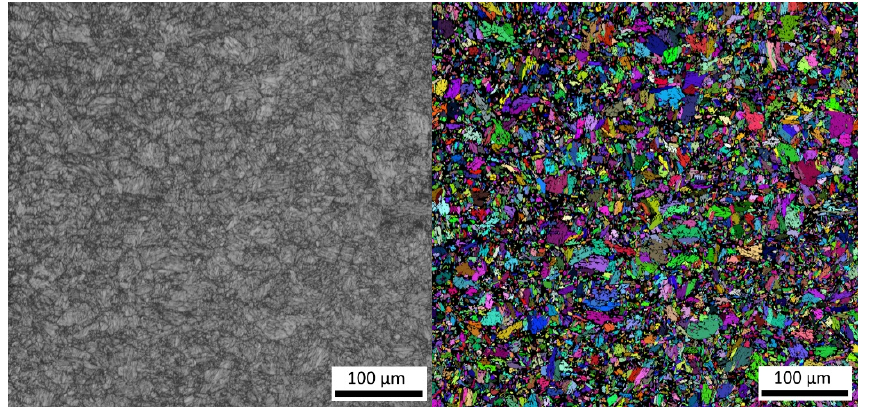
Figure 1. The martenzite–bainitic structure ( left ) and EBSD grain size analysis ( right ) of tested S960MC steel (HV 20 kV, step size 0.2 um).